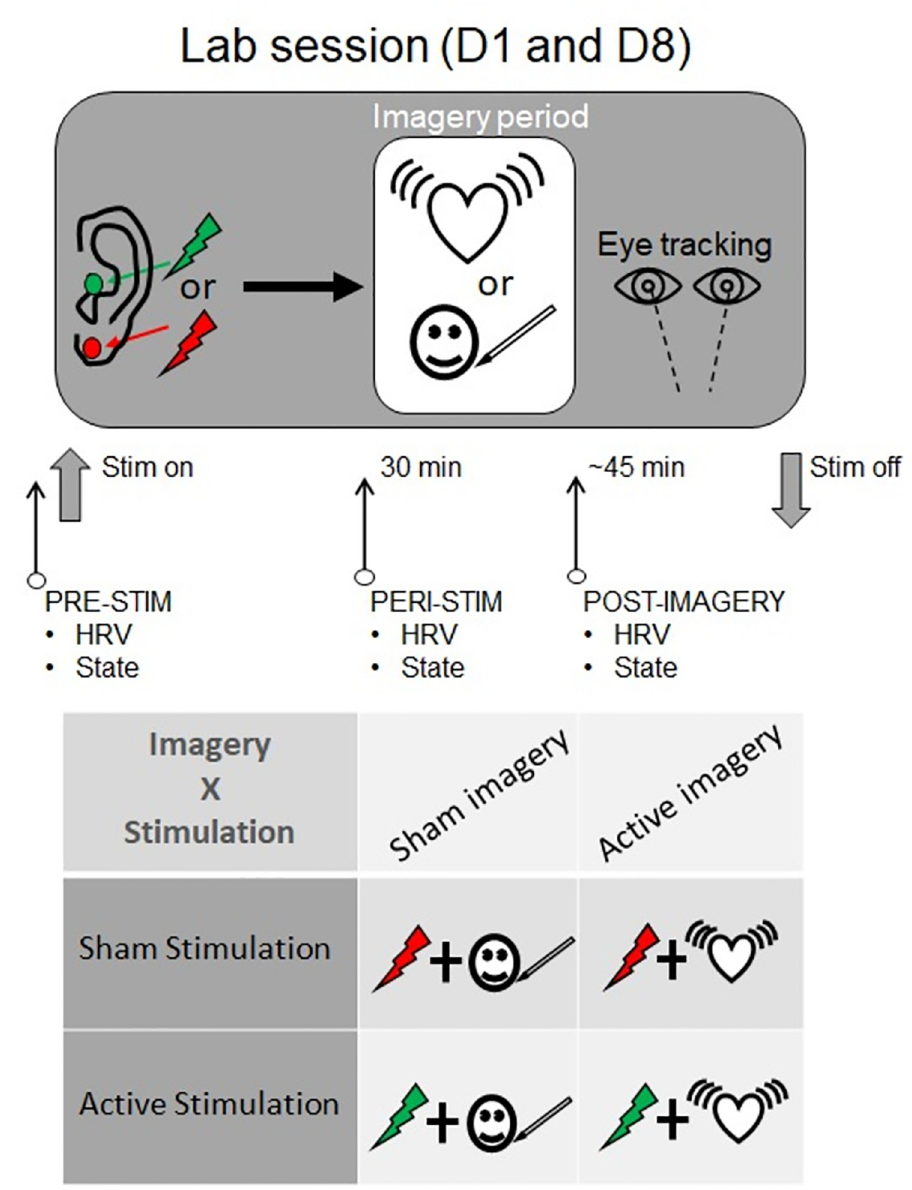
Fig 2. Procedural sequence for the two lab sessions (top panel). PRE-STIM refers to the assessment period immediately before the stimulator is switched on. PERI-STIM (before the imagery tasks) assessments occur after 30 min of continuous stimulation in the absence of any concurrent task. POST-IMAGERY measures are taken ~15 min after the PERI-STIM measures on lab Session 1 (Day 1) and ~10 min after on Session 2 (Day 8). The different timings are a result of the briefer recorded instructions used on Session 2 (i.e. only section 3 of the audio imagery instructions is played to participants; see details under Mental Imagery Tasks ). The block of ‘State’ measures at the three timepoints consists of the iPANAS, SCSC Scale, 5-items from the SMS, TPAS and VFIQ (see text for details). The bottom panel illustrates the 2 x 2 design and the four conditions used in the study. Participants complete the same stimulation and imagery procedures on both lab sessions (and during the intervening at-home